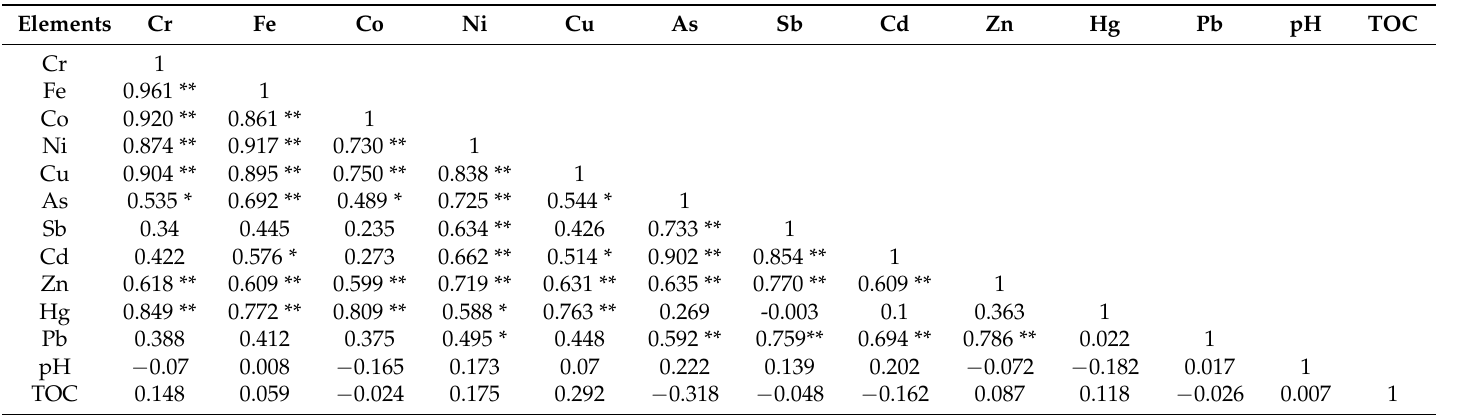
Table 5. Pearson’s correlation coefficient between individual trace elements and soil